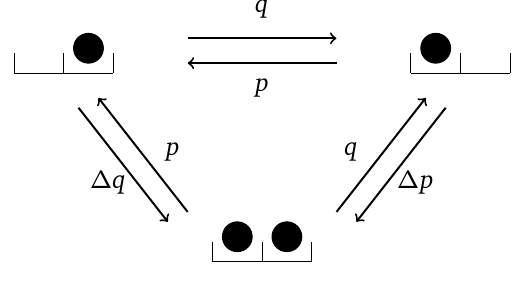
Figure 1: Non vanishing rates between the different configurations at two neighboring sites in the